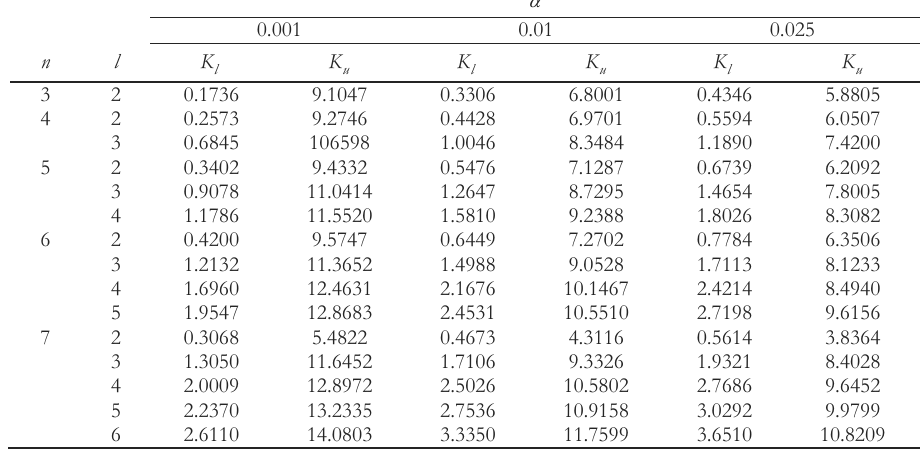
Critical values for Test 3 with SRSS data from the exponential distribution